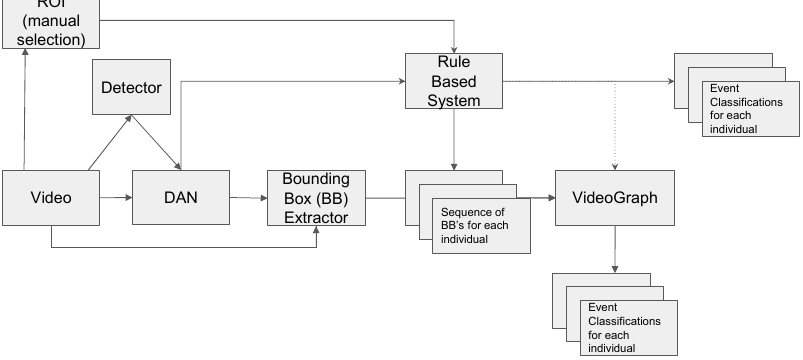
Figure 3. Our proposed video event classification pipeline architecture. Both rules-based and deep learning-based algorithms are included for activity recognition. ROI stands for Region of Interest; BB stands for Bounding Box.